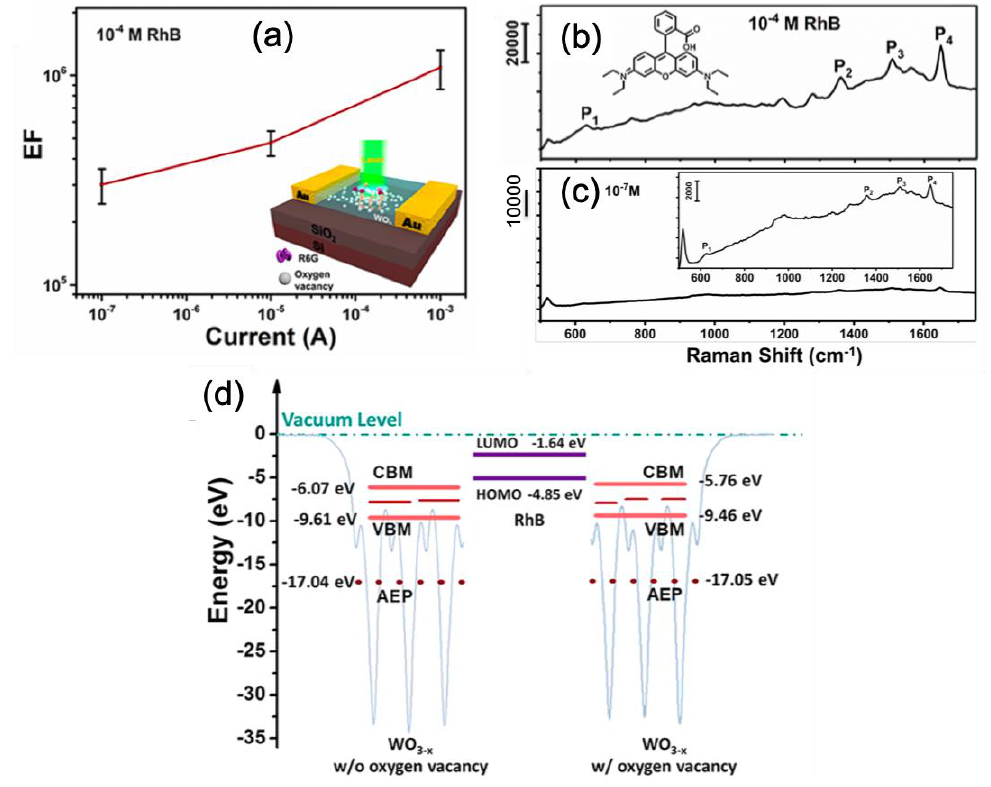
Figure 7. ( a ) Enhancement factor for SERS signal versus leakage current for a rhodamine B (RhB) concentration of 0.1 mM, and the inset represents the structure scheme. SERS spectra of RhB recorded for a leakage current of 1 mA with an RhB concentration of ( b ) 0.1 mM and ( c ) 0.1 µ M (at detection limit (LOD)), and the insets of the figures ( b ) and ( c ) represent a molecular scheme of RhB and a zoom on the SERS spectrum, respectively. ( d ) Illustration and alignment of energy levels of WO 3 − x film without oxygen vacancies (at left), RhB molecule (at center), and WO 3 − x film with oxygen vacancies (at right). All the figures are reprinted (adapted) with permission from [99], Copyright 2019 American Chemical